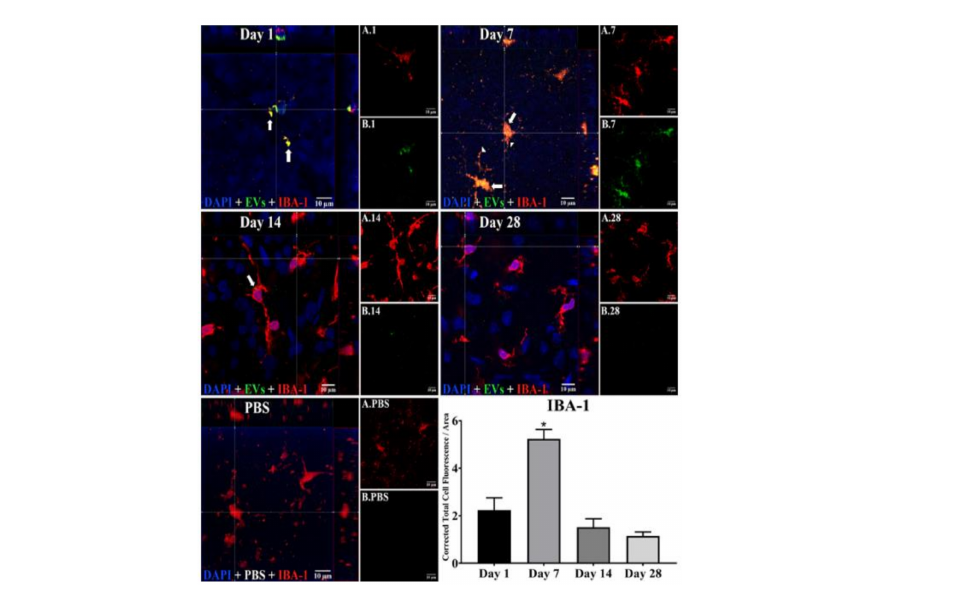
Figure 2. Staining for EVs in microglia in flat mounts of rat retinas. The results show that EV staining in microglia peaks at 7 days after intravitreal injection of EVs. Fluorescent colors are as follows: anti-IBA–1 (red), EVs (green), DAPI (blue). Orthogonal 3D projection shown as a composite for each day’s panel, and red channels (A.1, A.7, A.14, A.28) and green channels (B.1, B.7, B.14, B.28) for a representative z-stack alongside each day’s composite. PBS injected control is bottom left; A.PBS is red channel, and B.PBS is green channel. Scale bars (10 µ m) are on the bottom right of each panel. Arrows = overlap (co-localization, yellow or yellow-orange) of green EVs and anti-IBA-1 in microglia. Arrowheads point to vesicular-appearing staining pattern of EVs in microglia. 100x. Bottom right: green fluorescence intensity ( Y axis) was expressed relative to background. N = 4 per time point * p < 0.05 vs. day 1.